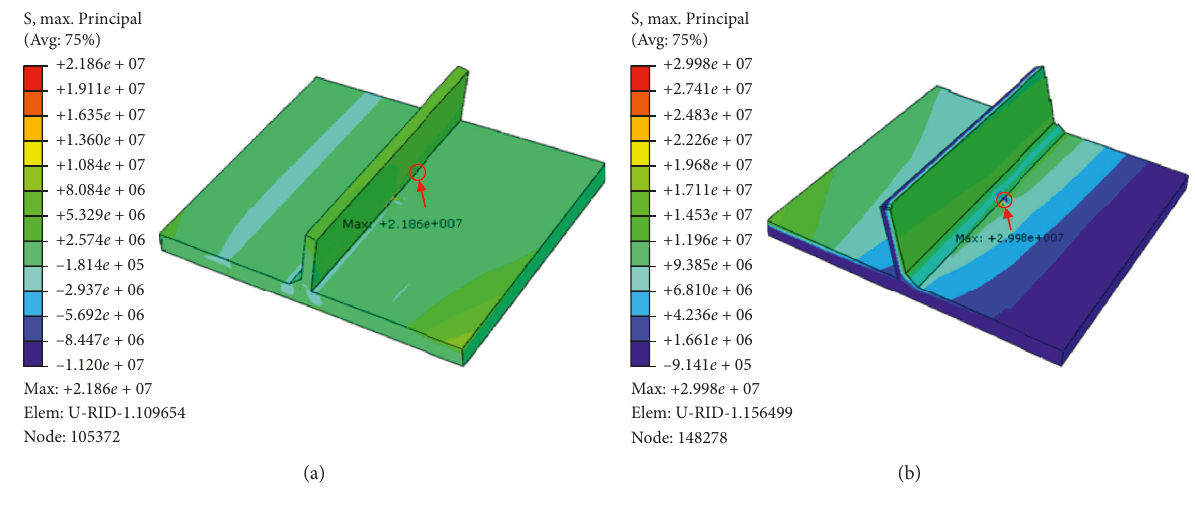
Figure 9: The maximum principal stress nephograms for crack type. (a) Crack from the welding root of top deck (type a) and (b) crack from the welding toe of top deck (type b).